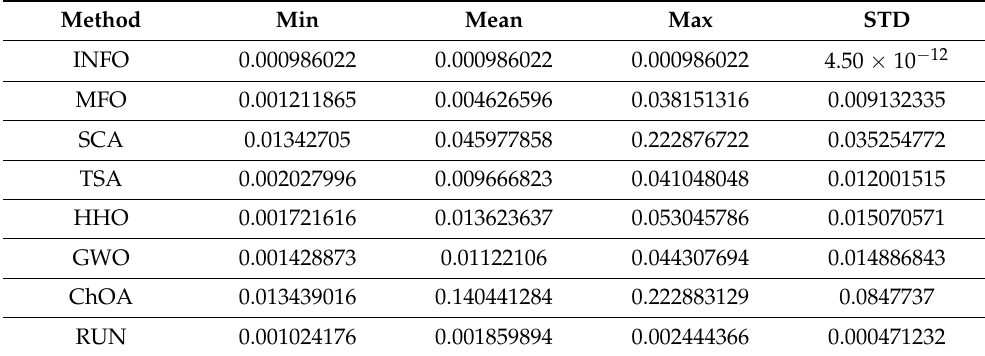
Table 6. Statistical results for the SDMSC.